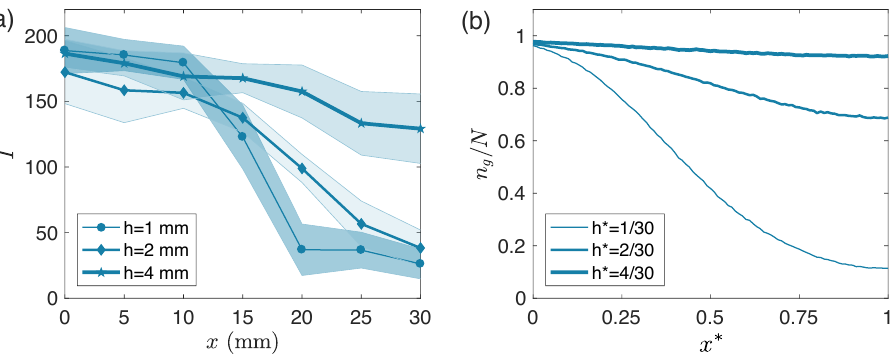
Figure 6. ( a ) Experimental measurements of fluorescent intensity profile at 16 h for three different secondary interior chamber heights. Interior secondary chamber dimensions: L × w × h = 30mm × 30mm × h , with h = 1 mm, 2 mm, or 4 mm. Shaded regions on each side represent one standard deviation of measurements obtained from at least three independent experiments. ( b ) Prediction of model at t ∗ = 5.00 for three different domain heights with w ∗ = 1 and L ∗ = 1. To simulate height h ∗ = 0.03, we use P g = 5 × 10 − 4 and ˙ m ∗ = 1000; for h ∗ = 0.06, we use P g = 5/4 × 10 − 4 and ˙ m ∗ = 2000; and for h ∗ = 0.13, we use P g = 5/16 × 10 − 4 and ˙ m ∗ = 4000. Each curve represents the average result over 500